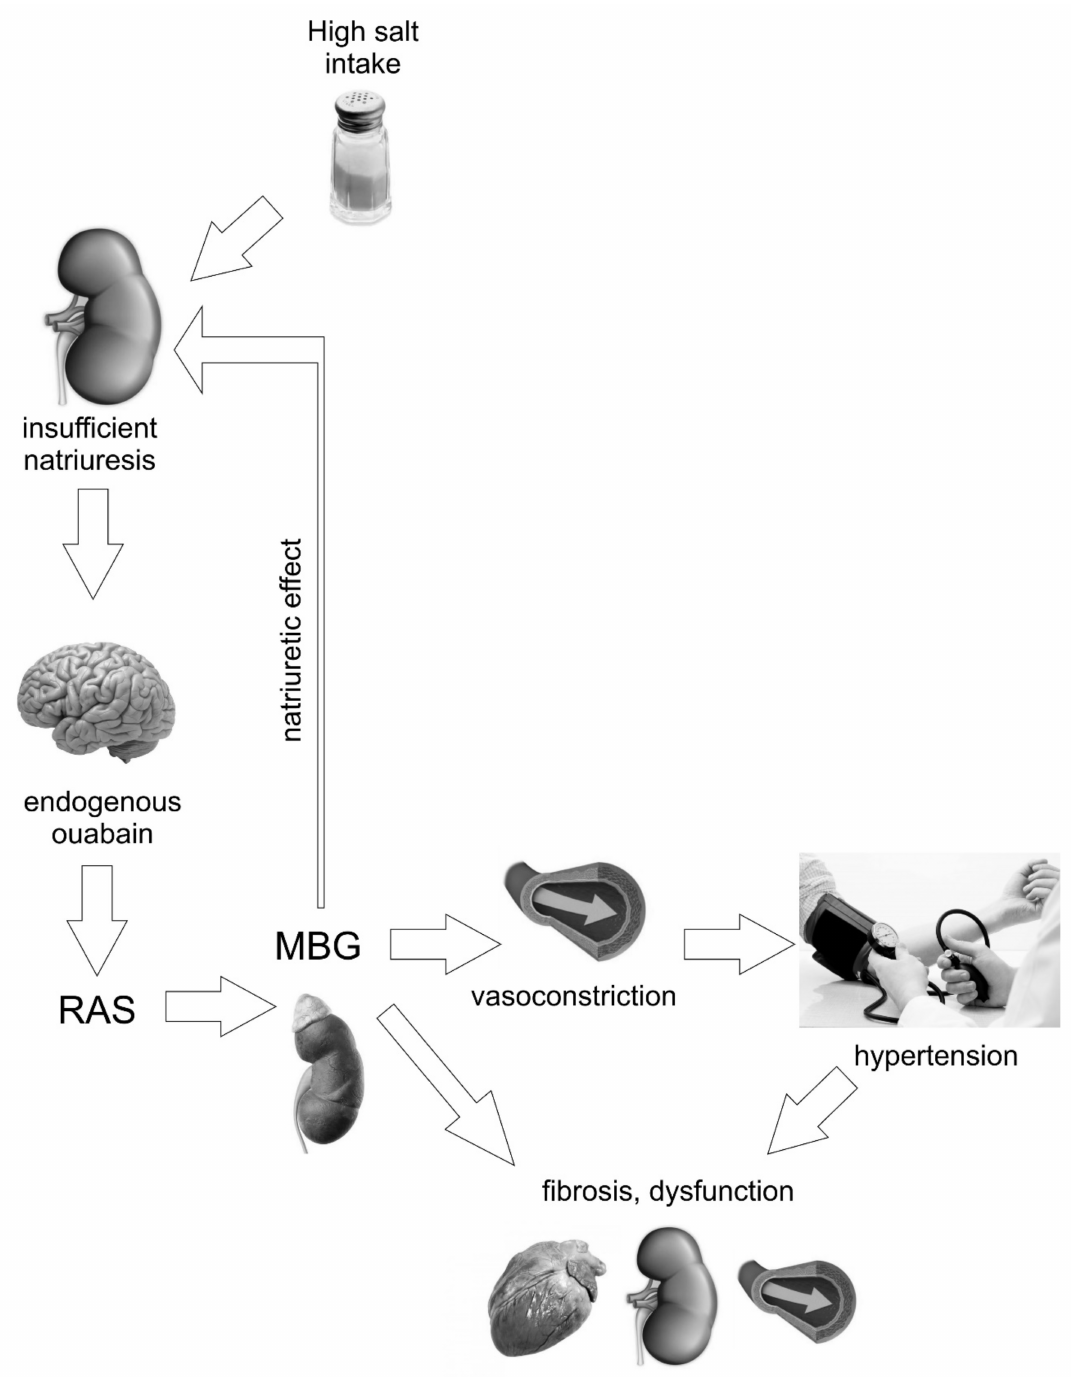
Figure 2. A possible mechanism of salt-induced hypertension and organ damage in humans. NaCl loading stimulates brain endogenous ouabain. Endogenous ouabain in the brain activates the local renin-angiotensin system (RAS) as well as sympathetic nervous system (SNS). These actions stimulate renin-angiotensin system in adrenal cortex and release of adrenocortical marinobufagenin (MBG). MBG is secreted in order to facilitate natriuresis, but at the same time MBG induces vasoconstriction which increases blood pressure and promotes fibrosis leading to permanent heart, kidney, and arterial damage and